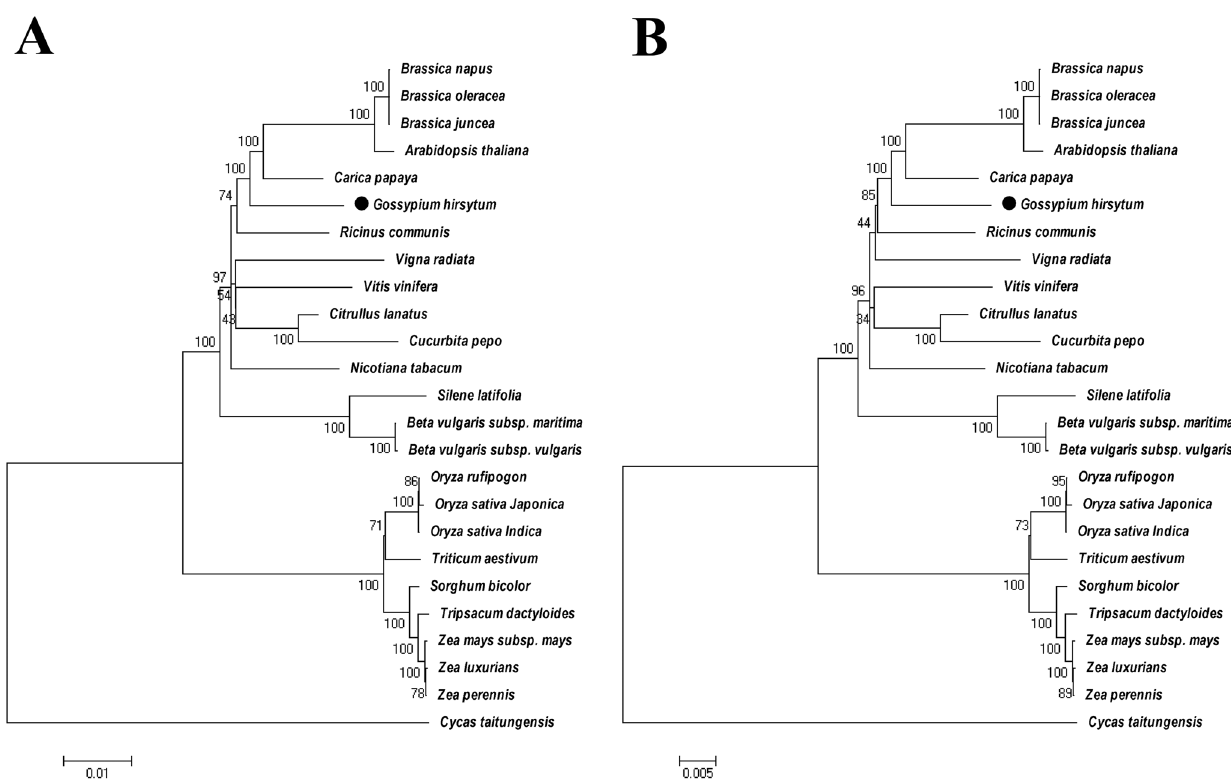
Figure 7. Phylogenetic trees of 21 respiratory related genes. The ML tree (A) and the NJ tree (B). Genes used were listed in Table S4, including 17 respiratory complex genes and four cytochrome c biogenesis genes.